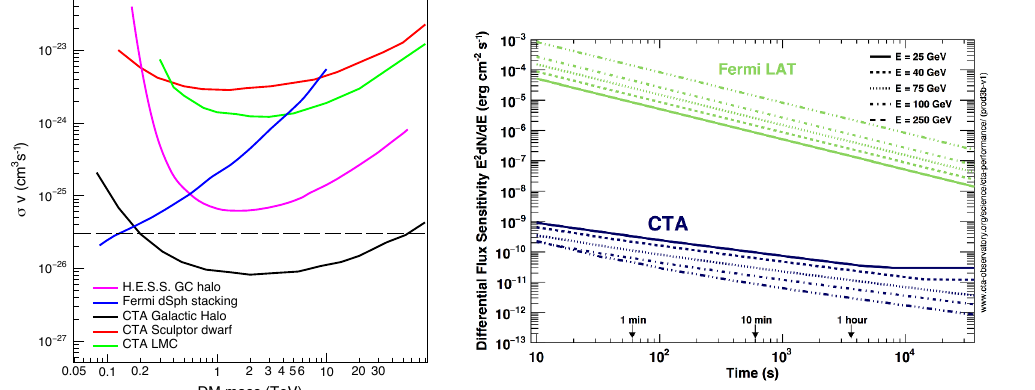
 v ) for dark matter annihi- h i